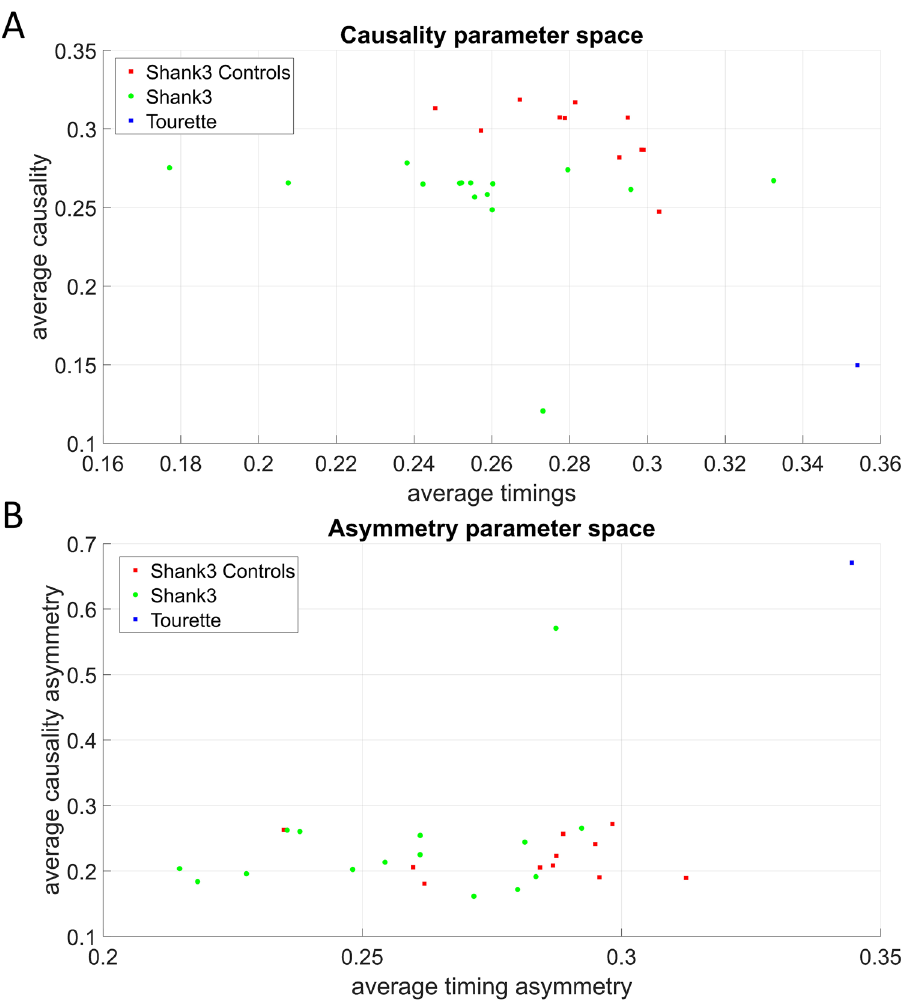
Figure 7. Parameter spaces reveal differences across ASD-SHANK3 deletion participants and the youngest controls of the study. ( A ) Normalized values of average causality and motor timings separates these